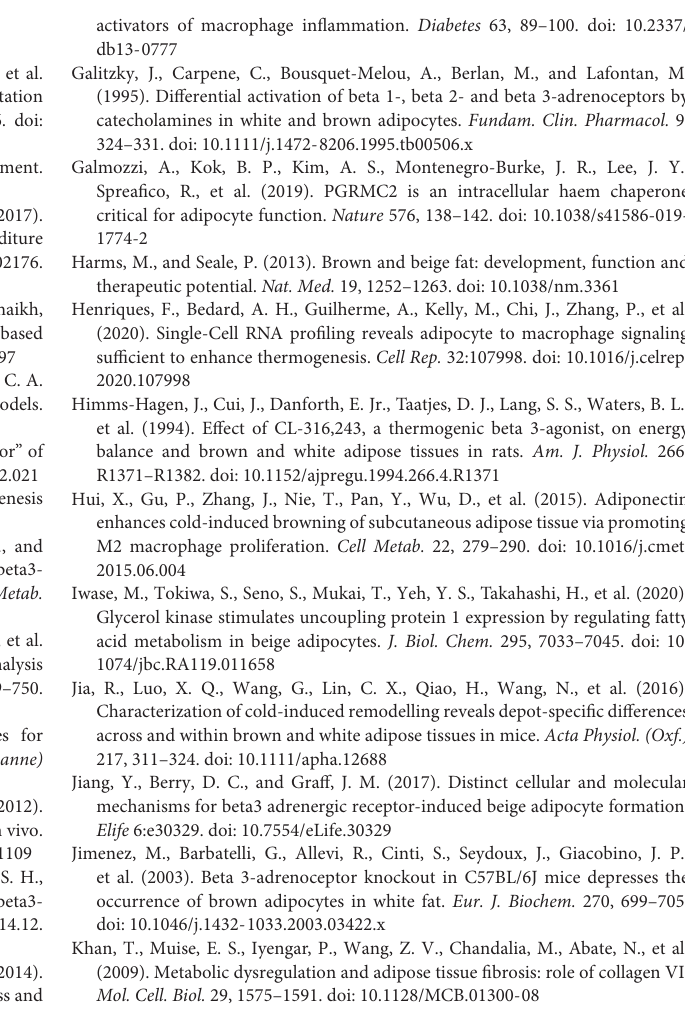
Supplementary Figure 1 | Effect of chronic cold exposure and CL316,243 administration on systemic energy homeostasis. (A–D) Body weight gain, food intake, serum triglyceride (TG), and total cholesterol (TC) levels of mice treated with RT or cold (A,B) and PBS or CL (C,D) . N = 6 per group. Data are presented as mean ± SEM and ∗∗ P < 0.01 compared to control group. Supplementary Figure 2 | Gene ontology (GO) biological process analysis of commonly regulated genes in iWAT of mice upon cold exposure from two RNA-seq datasets. (A,B) GO enrichment analysis for overlapped upregulated (A) and downregulated (B) DEGs from iWAT of mice under cold exposure as shown in GSE86338 and GSE164219 datasets. Supplementary Figure 3 | Gene ontology (GO) biological process analysis of commonly regulated genes in iWAT of mice upon CL administration from two RNA-seq datasets. (A,B) GO analysis for overlapped upregulated (A) and downregulated (B) DEGs from iWAT of mice under CL administration as shown in GSE86338 and GSE129083